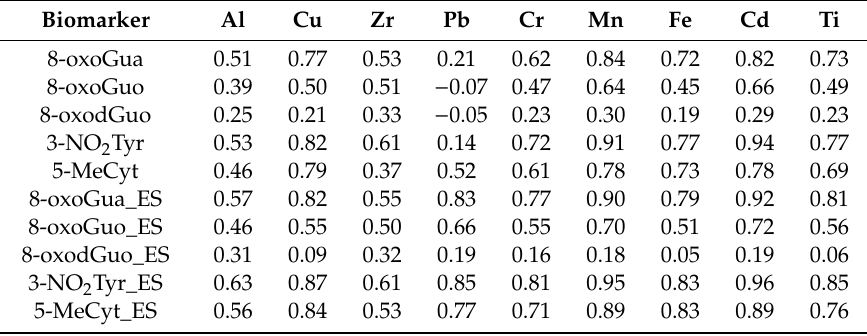
Table 5. Pearson’s correlations between elements and oxidative stress biomarkers in pooled data and in workers at the end of the